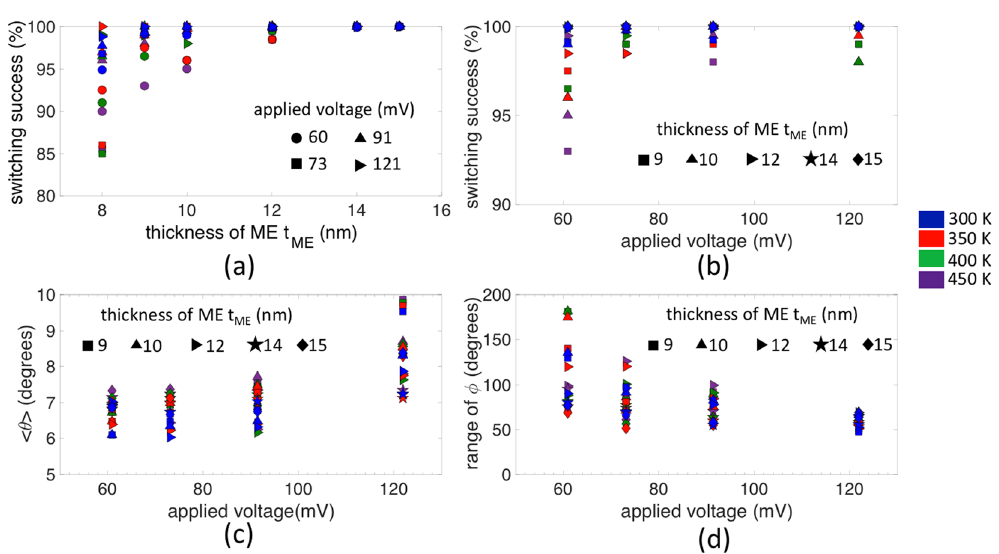
Figure 5. ( a ) Plot illustrating the dependence of the switching success on the thickness of the ME cell t ME , ( b ) impact of the applied voltage on the switching success which stems from the effect on the detected mean amplitude ( θ ) and range of the phase ( φ ) of the spin wave as shown in ( c ) and ( d ), respectively. Symbols illustrate different applied voltages in ( a ) and thickness of the ME cell t ME in ( b – d ) while colors indicate different temperatures (300 K–450